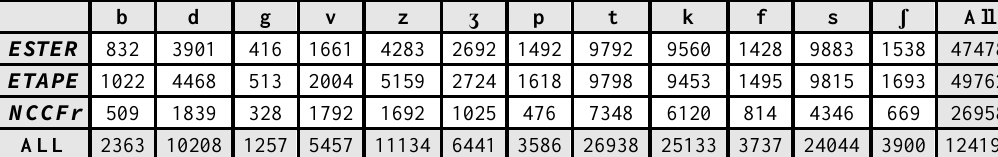
Table 1. Number of each coda in each of the three corpora.